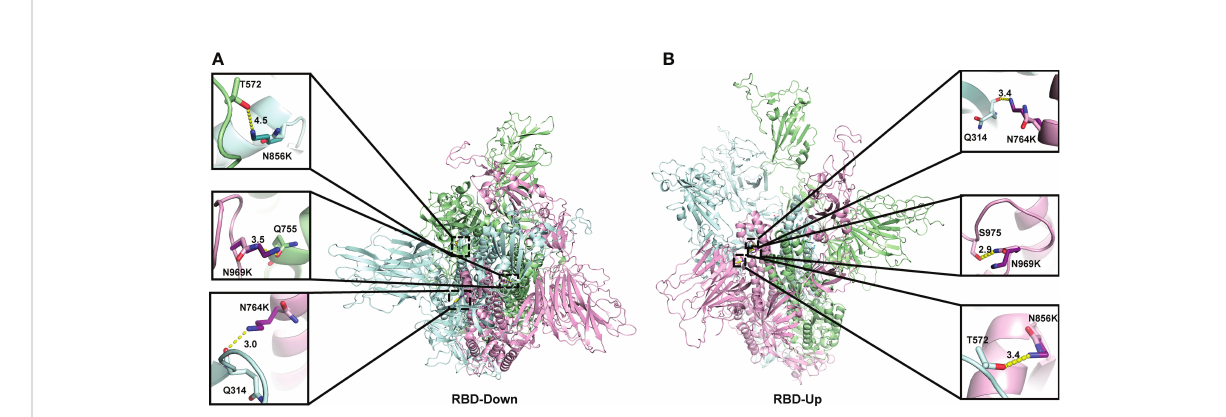
FIGURE 3 Location of three N to K mutations in the central core region of the homology model of Spike protein. The monomers of the Spike proteins in open (A) and closed (B) were shown in ribbons with different colours (pink, green, cyan). Side chain atoms of both prototype and Omicron residues were shown in sticks with the Carbon atoms in light and dark colours, respectively. The residues making Hydrogen bond interactions with prototype and Omicron residues are shown in sticks. Hydrogen bond interaction was shown in yellow dash line. The zoom-in versions of the interactions were shown next to the Spike